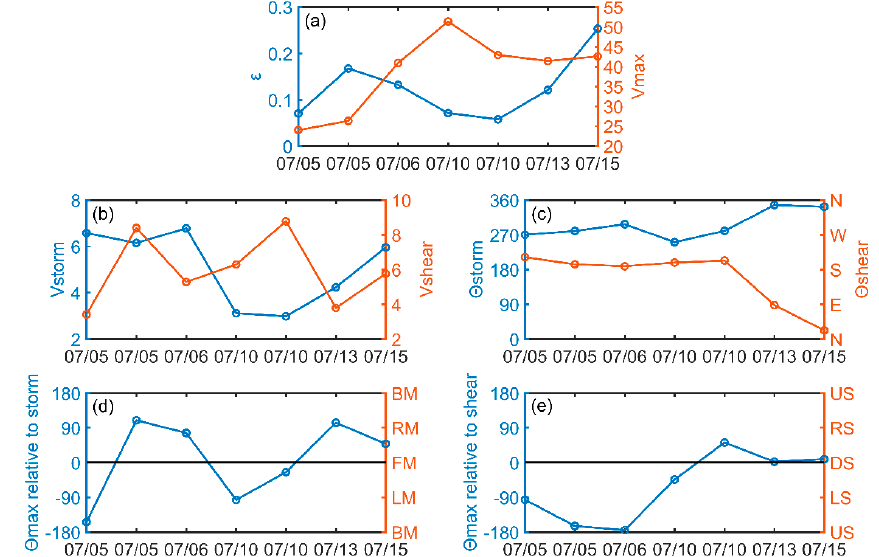
Figure 15. Time series of key parameters of typhoon Nangka: ( a ) Asymmetry parameter ( ε ) and TC intensity ( V max ); ( b ) translation speed ( V storm ) and environmental vertical wind shear magnitude ( V shear ); ( c ) TC motion direction ( θ storm ) and environmental vertical wind shear direction ( θ shear ); ( d ) Azimuth angle of wind maximum ( θ max ) relative to storm movement; ( e ) Azimuth angle of the wind maximum ( θ max ) relative to vertical wind shear. RM indicates that θ max is located on the right side of the TC motion, LM indicates that θ max is located on the left side of the TC motion, FM indicates that θ max is located forward of the TC motion, and BM indicates that θ max is located behind the TC motion. RS indicates that θ max is located on the right side of the wind shear, LS indicates that θ max is located on the left side of the wind shear, DS indicates that θ max is ‘ downshear ’, and US indicates that θ max is ‘ upshear